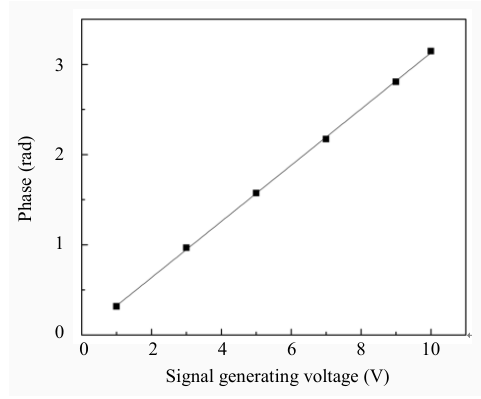
Fig. 7 Demodulated amplitude with different signal generating voltages at 10